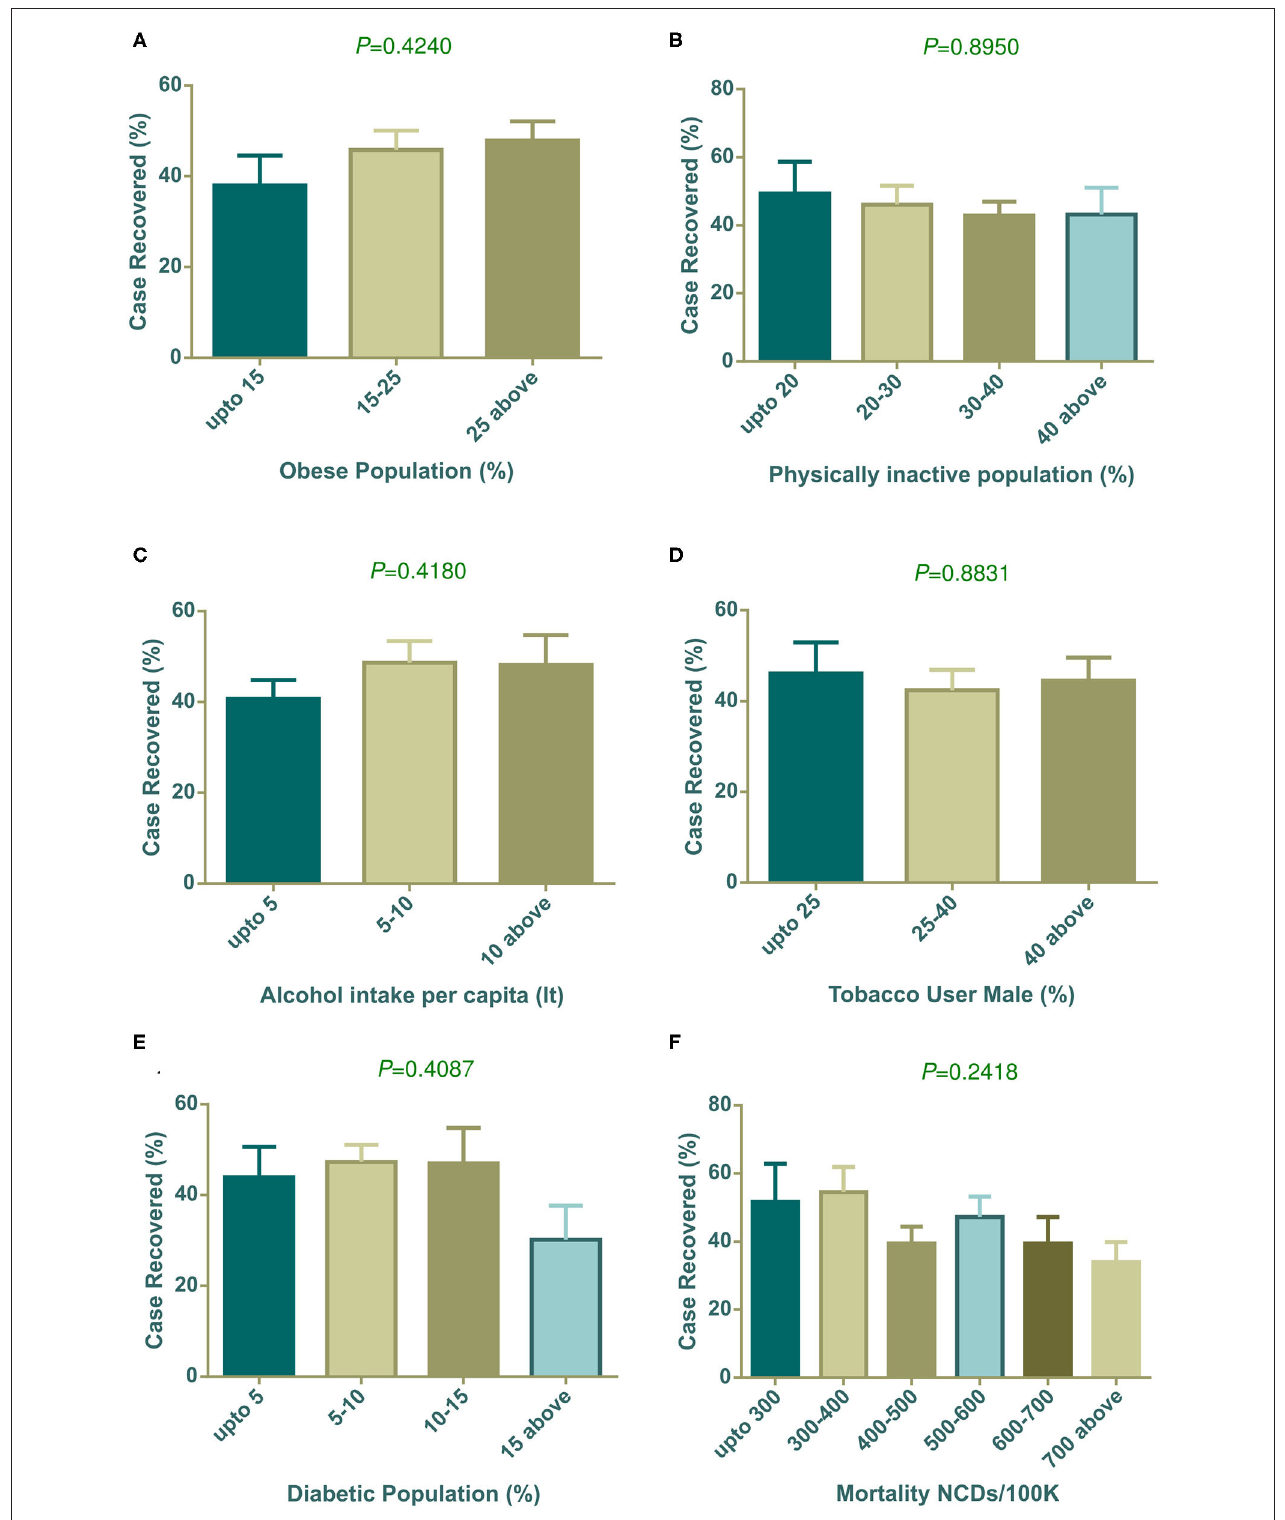
FIGURE 5 | COVID-19 case recovery (%) distribution based on countries grouped according to health indicators (A–F) . None of the parameters showed statistically significant variation among column means by one way ANOVA. Data presented are mean ± SEM.